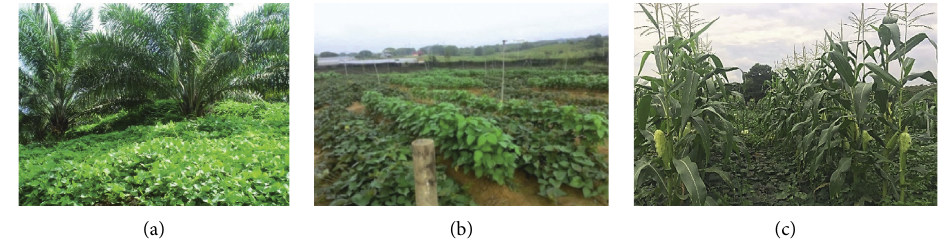
Figure 1: Examples of intercropping in (a) mixed intercropping of oil palm ( Elaeis guineensis L.) and leguminous cover crop ( Mucuna bracteata L.); (b) strip intercropping of soybean ( Glycine max L.) into sweet potato ( Ipomoea batatas L.); (c) strip-relay intercropping of corn ( Zea mays L.) and sweet potato (Ipomoea batatas L.). Photographs by Mohd Anim [20] (a) and Nur Arina [21] ((b) and (c),